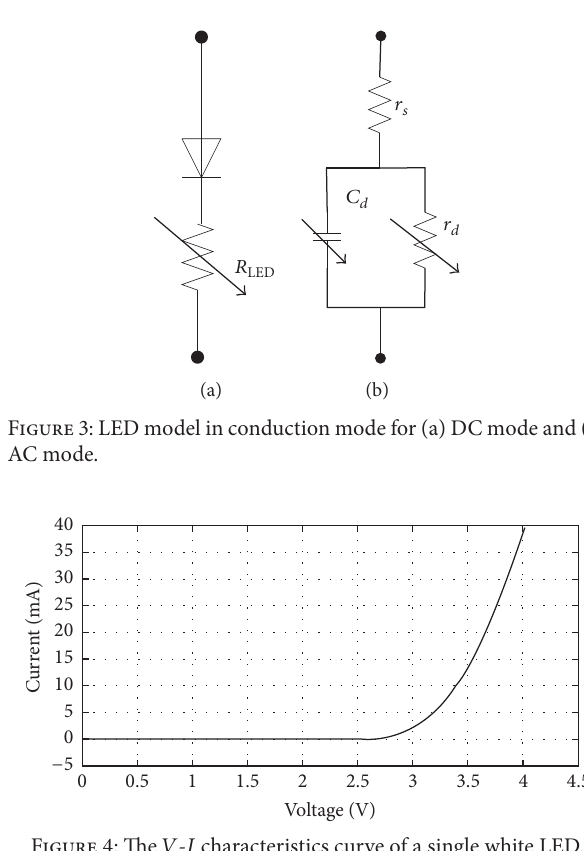
Figure 4: The 𝑉 - 𝐼 characteristics curve of a single white